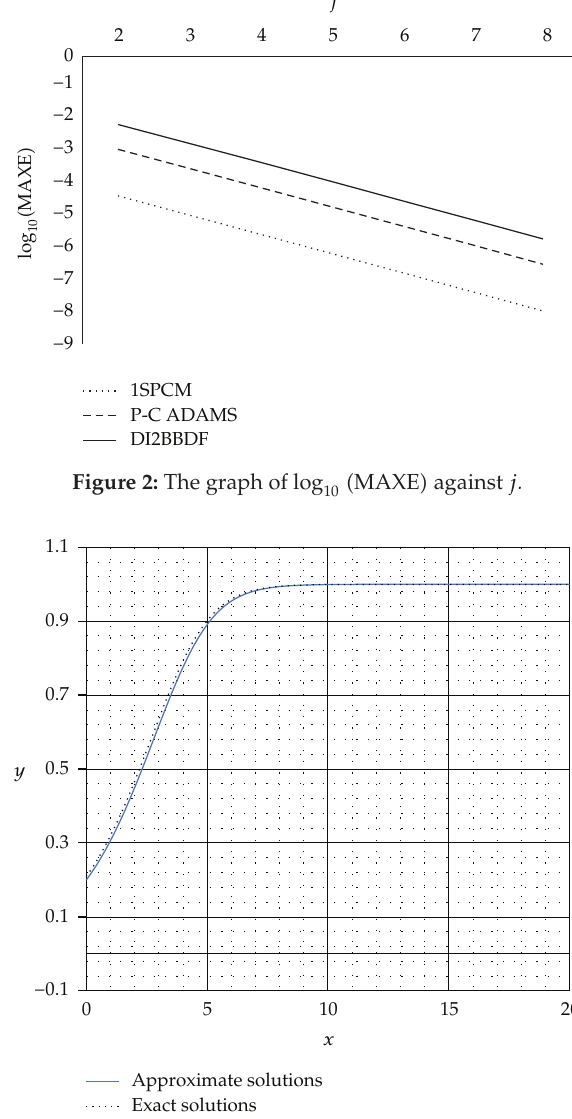
Figure 3: The graph of exact and approximate solutions against x ∈ (cid:6) 0 , 20 (cid:7) using h (cid:5) 0 .